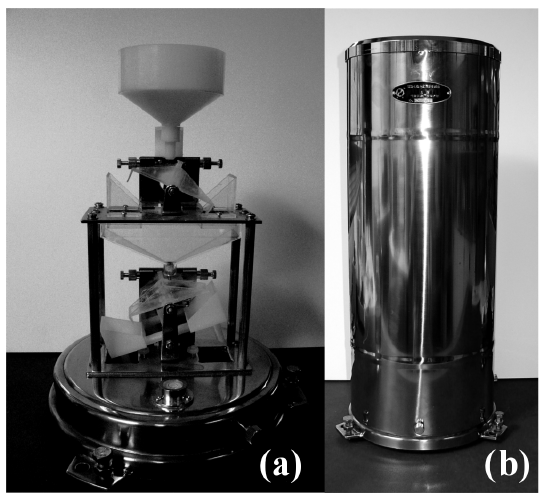
Figure 1. Shanghai SL3-1 (SL3): internal mechanism with a double layer of tipping buckets (a) and an external case (b)